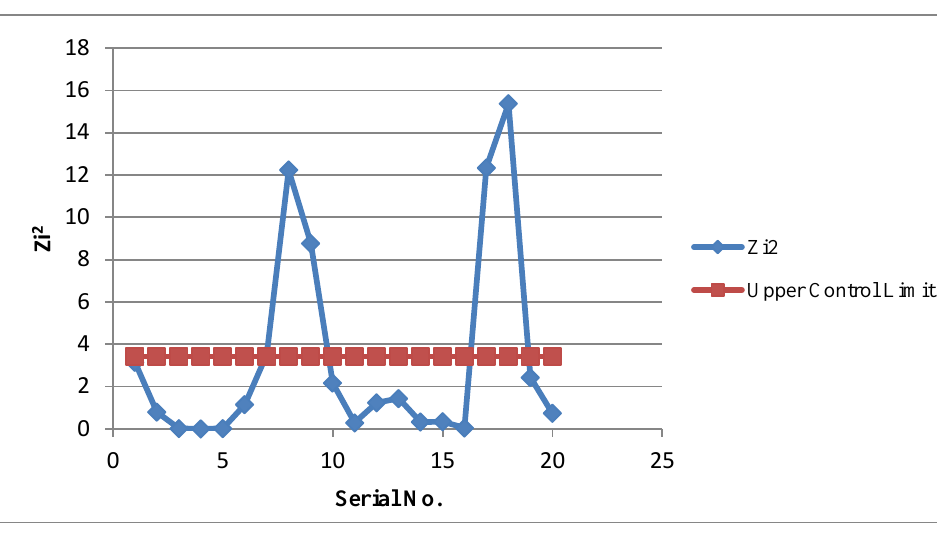
Figure 12. Generalized P Chart for Variable Sample Size in Marcucci